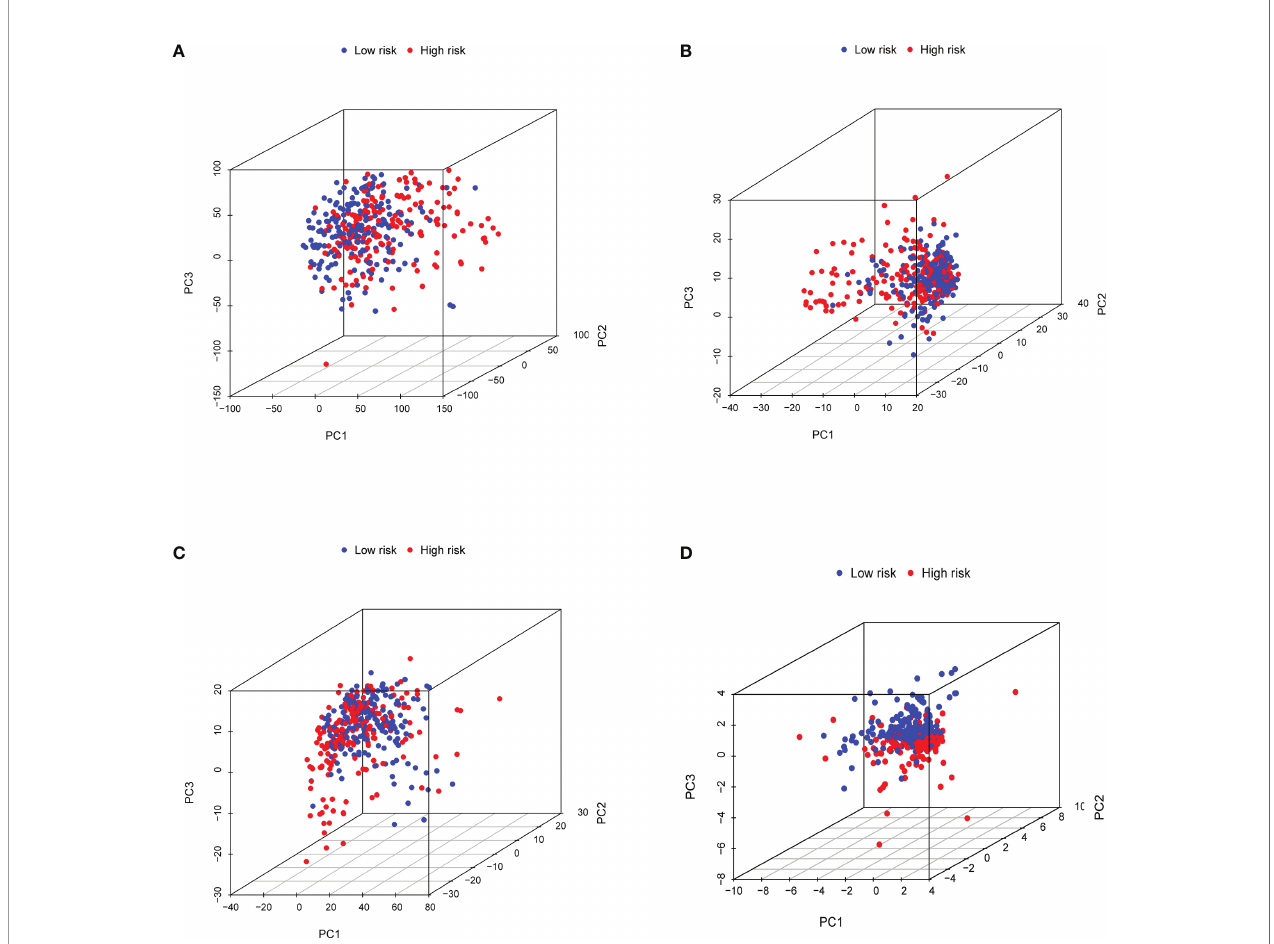
FIGURE 8 | Establishment and validation of a nomogram for predicting the overall survival of GC patients. (A) The nomogram was used for predicting the 1-, 3-, and 5-year OS of patients in the total set. Calibration curves of the nomogram predicting OS of 1 year (B) , 3 years (C) , and 5 years (D)